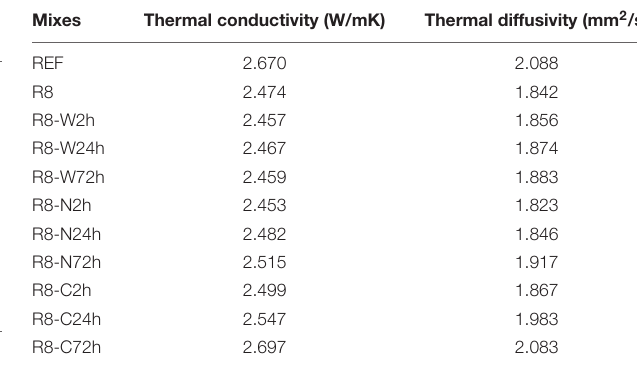
TABLE 4 | Results of thermal properties of